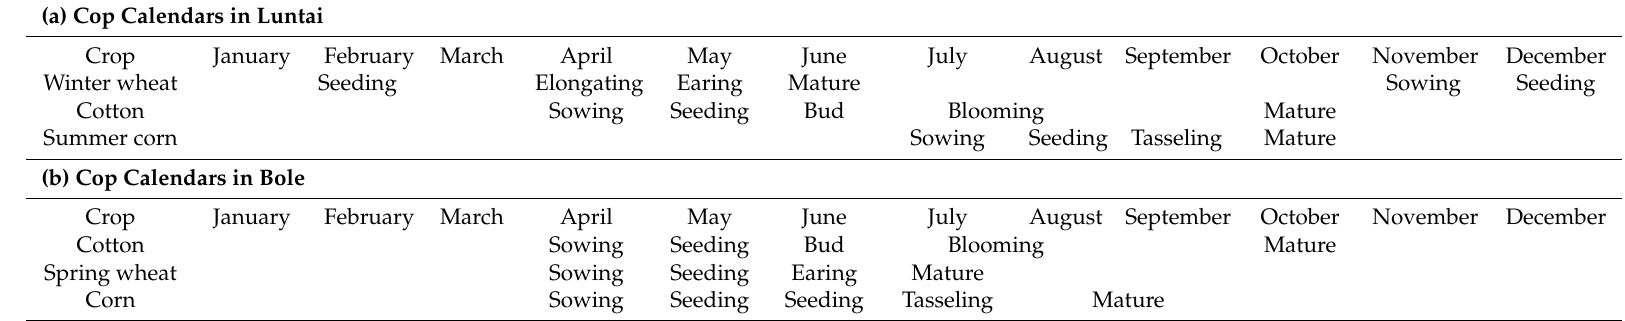
Table 3. The crop calendars of the main crops in Bole and